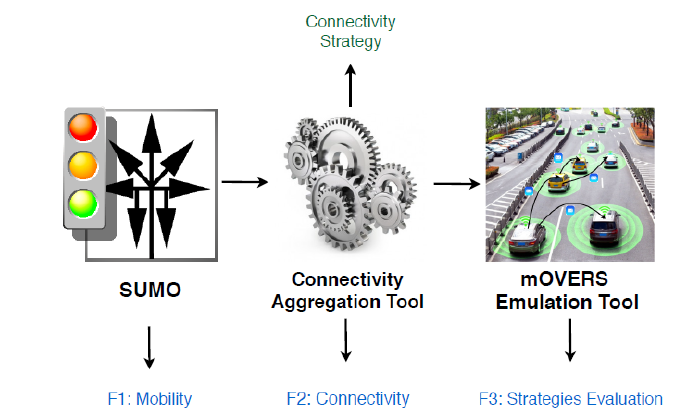
Figure 7. Software testbed